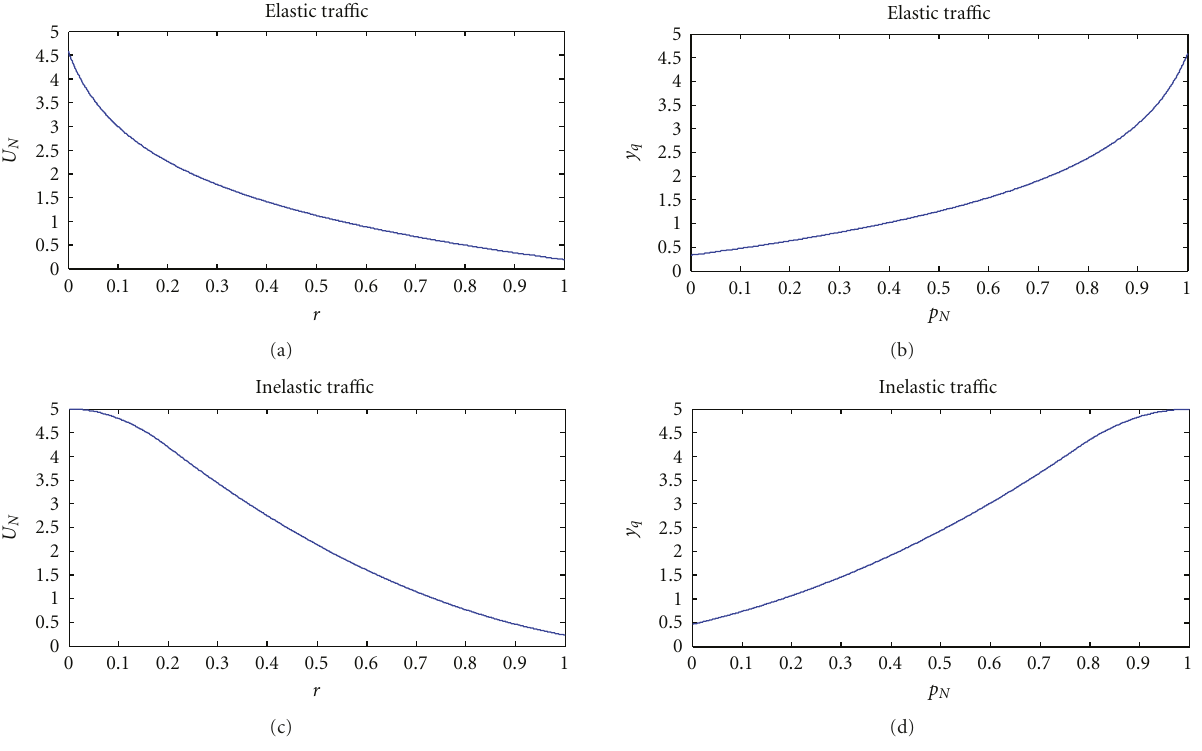
Figure 1: Two examples of U N ( r ) and y q ( p N